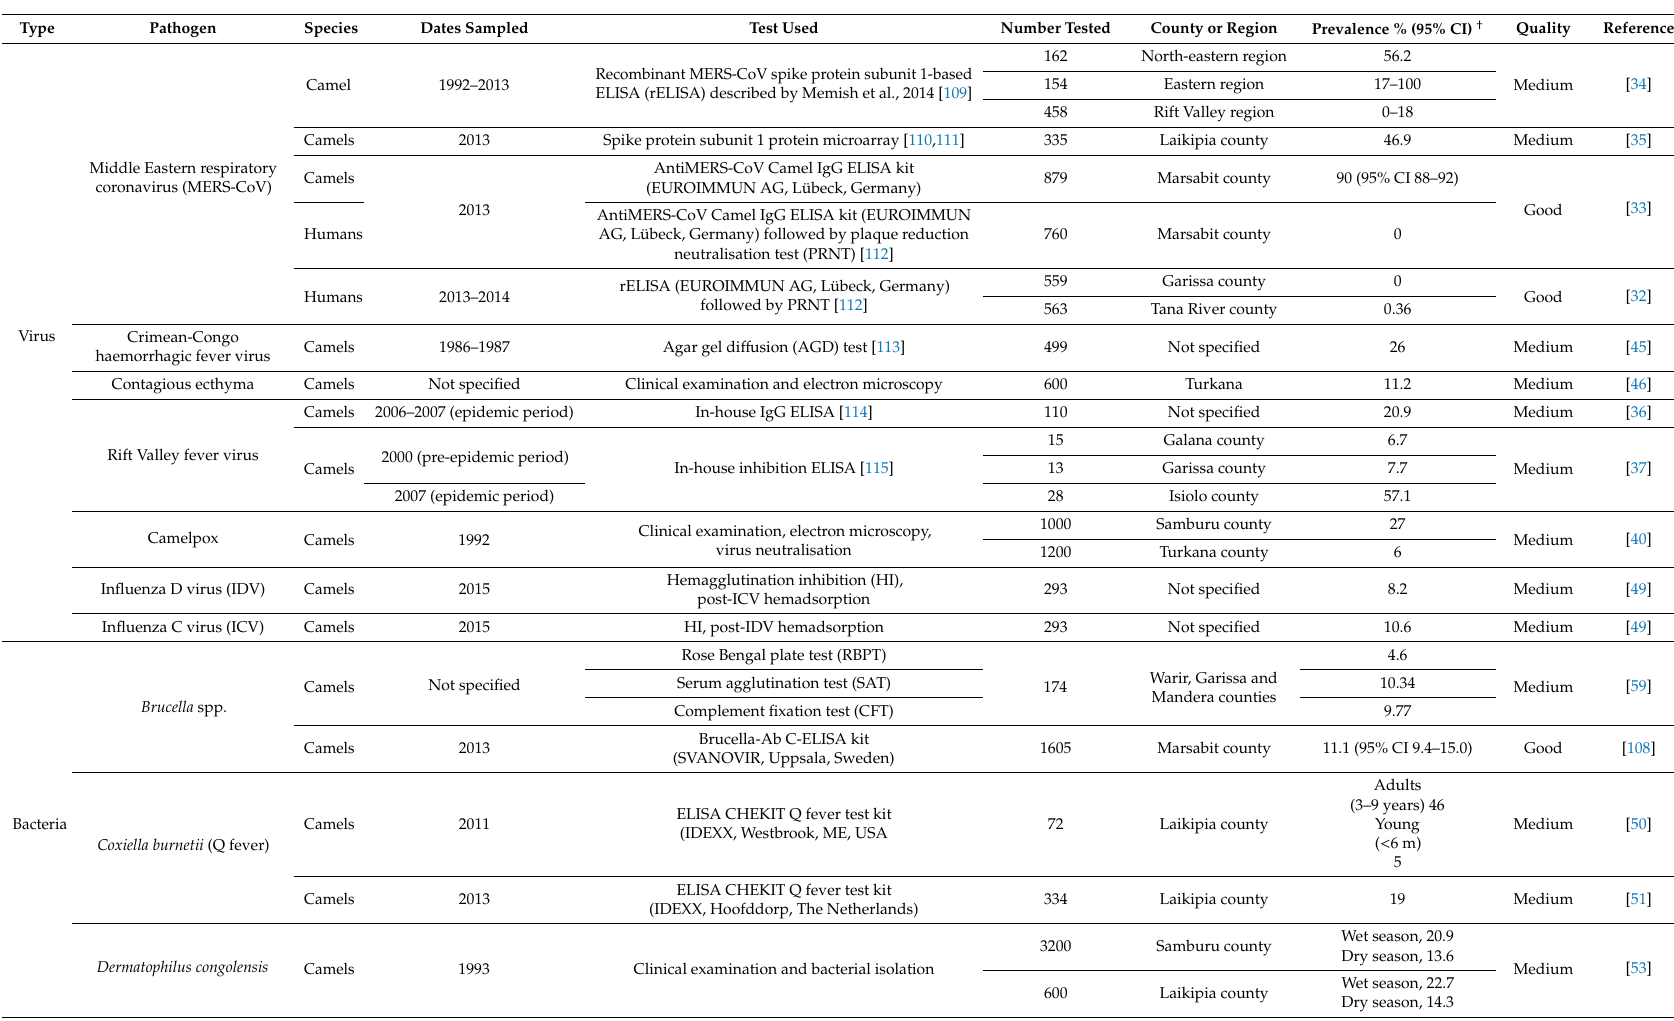
Table 4. Prevalence values reported in disease surveillance studies categorised as good or medium quality, based on criteria set out in Alonso et al. 2016 [24]. Type